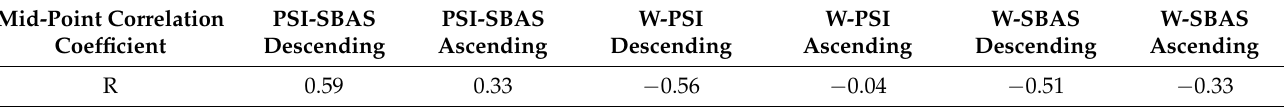
Figure 8. Displacements in the middle of the crest. Water level and PSI/SBAS ground displacement along the LOS at the middle of the crest (point b in Figure 7a). ( a ) The ascending mode and ( b ) the descending modes. Table 4. Correlations of displacement on the crest of the dam and water level (see Figure 8).